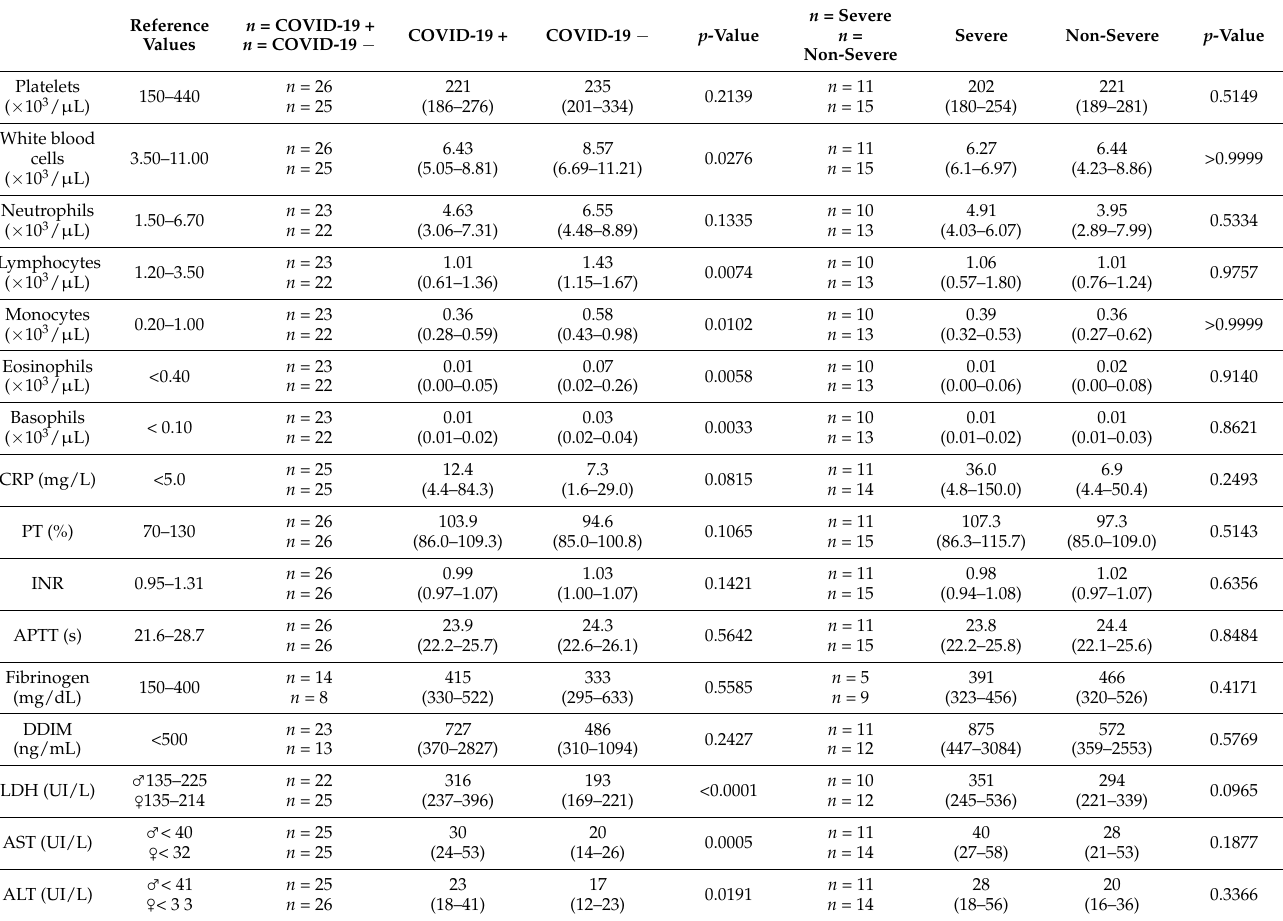
Table 1. Laboratory results of COVID-19-negative and COVID-19-positive patients as well as COVID- 19-positive “severe” and “non-severe”